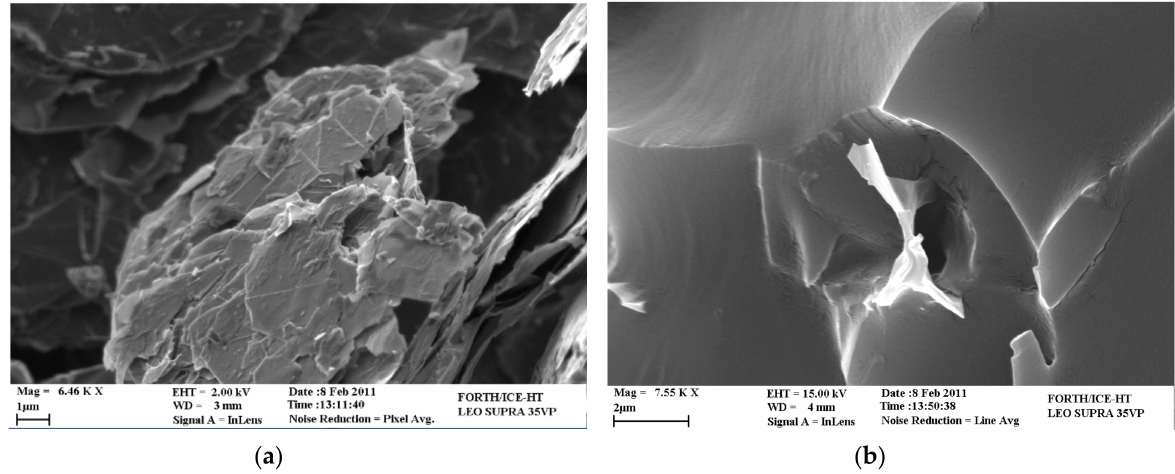
Figure 7. SEM micrographs of the ( a ) GNP agglomeration, and ( b ) buckled and rolled up GNP (0.5 wt.% Type 2 GNP nano-reinforced